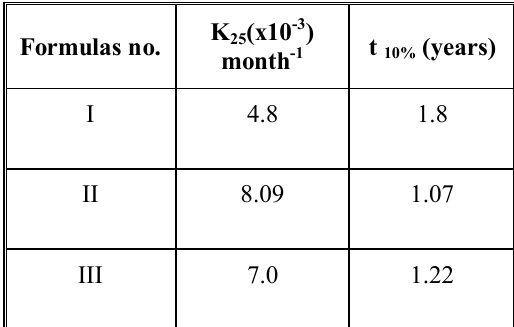
Table (4): Degradation rate constants at 25 0 C and